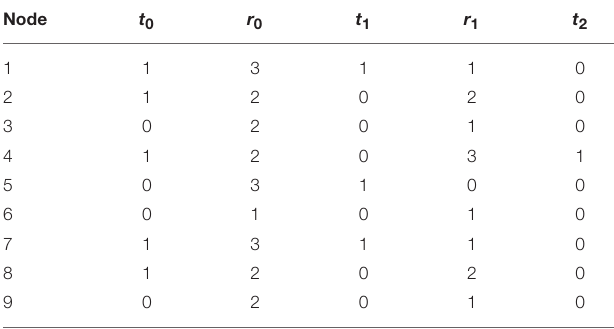
TABLE 1 | Illustration of the majority rule as used for Figure 2